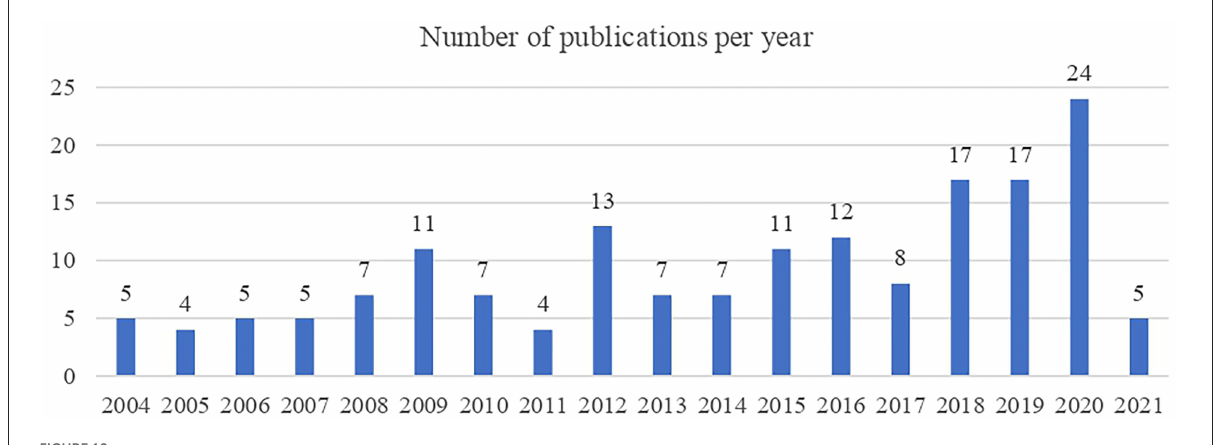
FIGURE10 The number of publications per year.